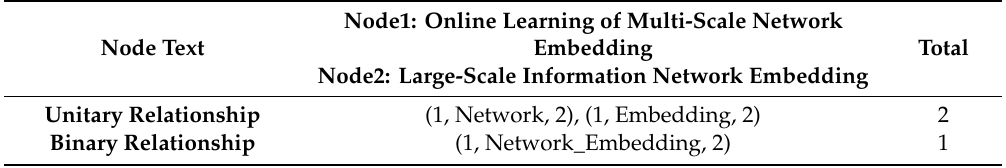
Table 1. Example of a unitary and binary